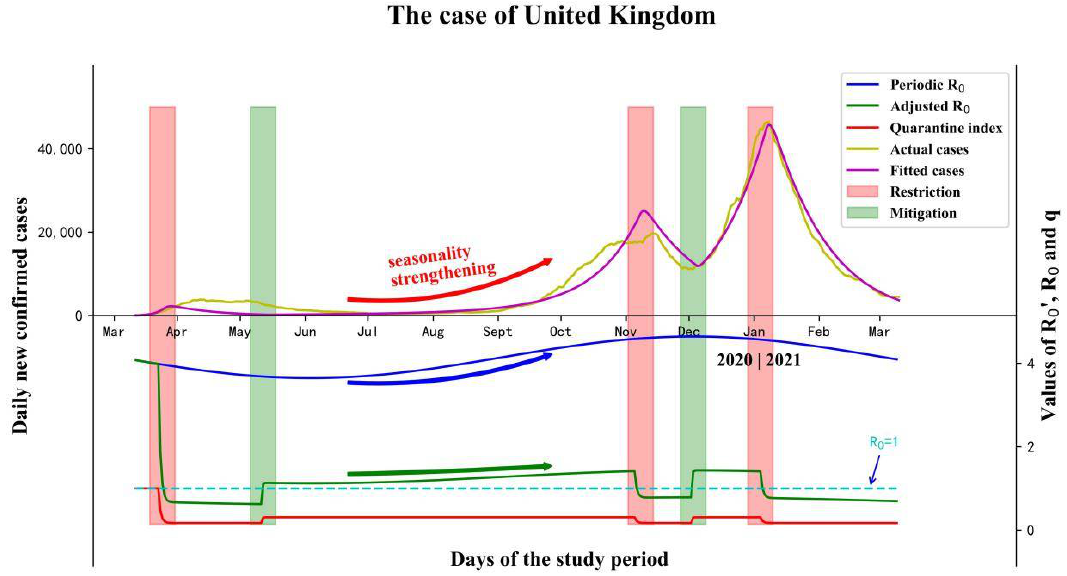
Figure 4. The co-influences of seasonality and control measures on the multi-stage COVID-19 epidemic in the case of the United Kingdom.